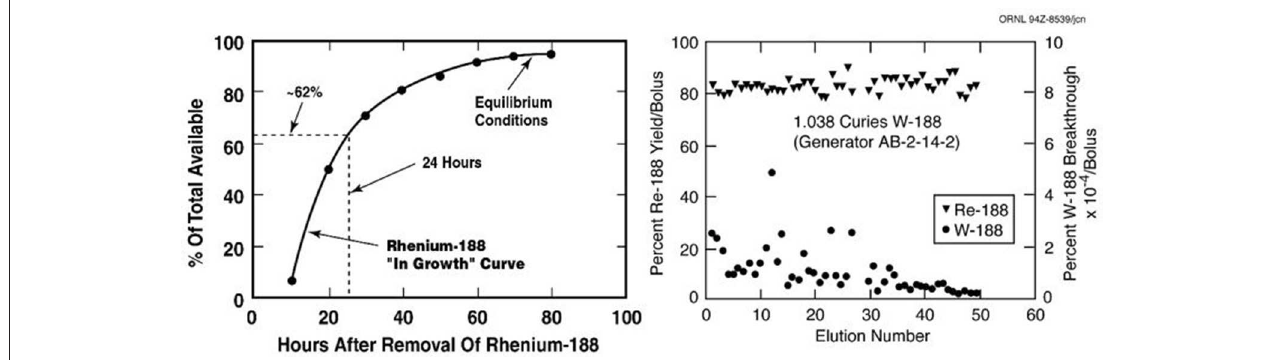
FIGURE 2 | The useful shelf-life of the ORNL alumina-based 188 W/ 188 Re generator shows consistently high 188 Re-perrhenate yields and low 188 W breakthrough over at least 2 months (Image property of ORNL, courtesy of Dr. Russ Knapp, Oak Ridge,